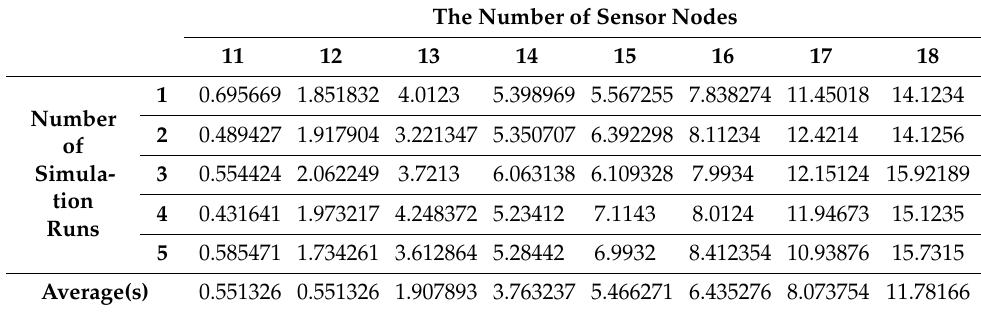
Table 2. Average spending time for the proposed